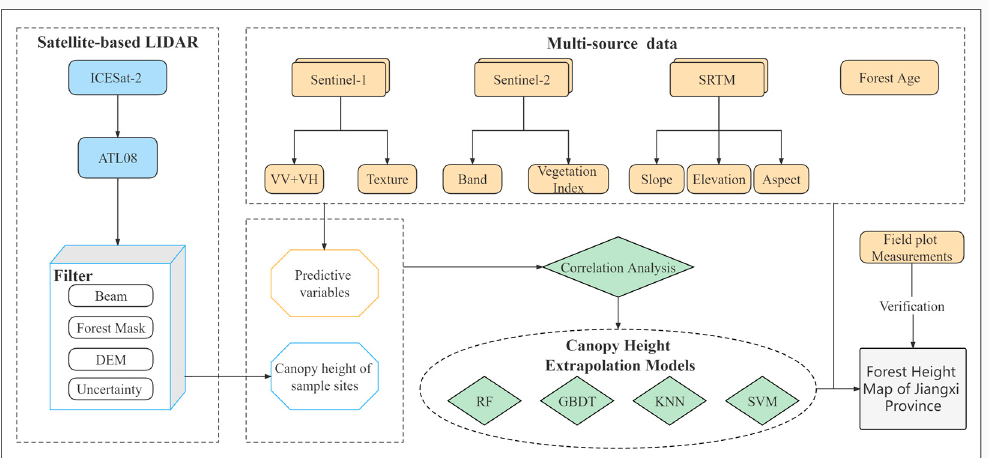
Figure 3. Workflow of integration of ICESat-2 and multi-source data for forest canopy height mapping in Jiangxi Province.